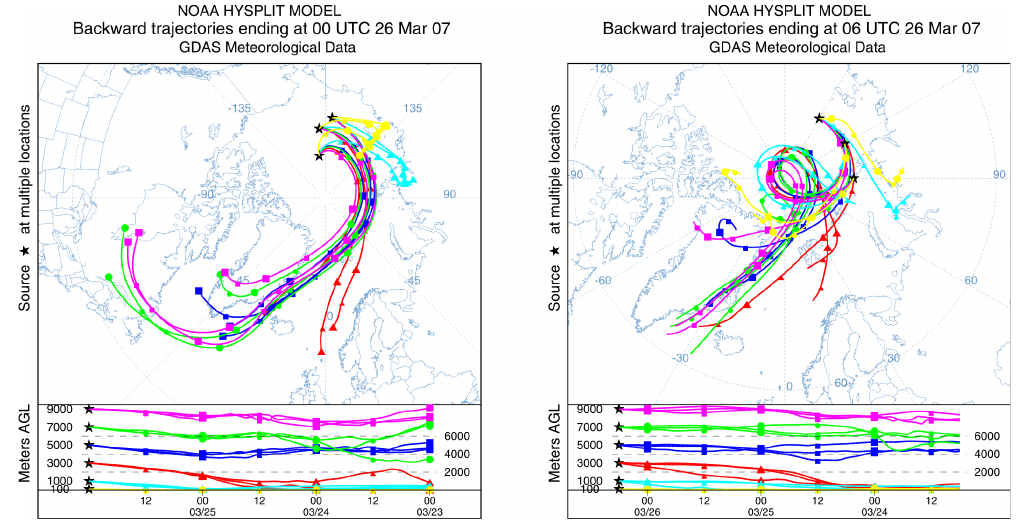
Fig. 9. HYSPLIT 72h backward trajectories started within the FLEXPART initialisation